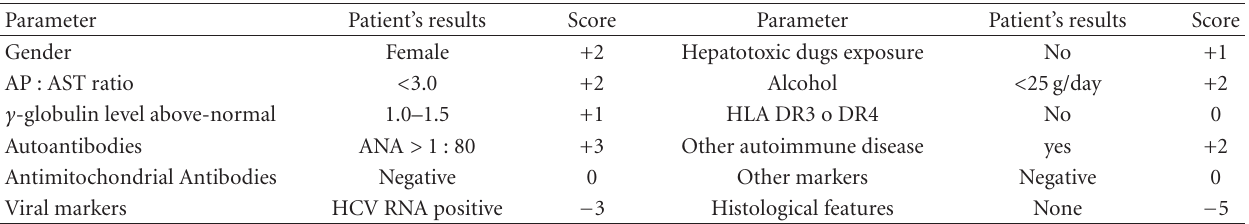
Table 2: International scoring system for diagnosis of autoimmune hepatitis. This scoring system defines a “definitive autoimmune hepatitis” for values > +15 before treatment; “probable autoimmune hepatitis” is defined for values between 10, and 15 before treatment. Our patient presented total score +5 (very unlikely diagnosis of autoimmune hepatitis).